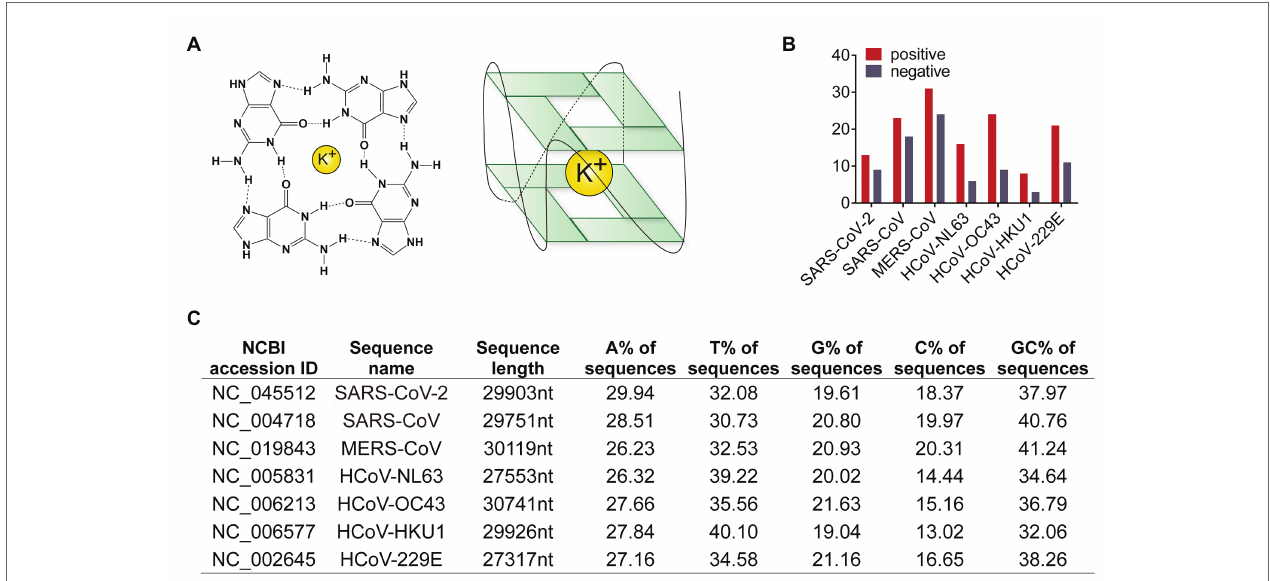
FIGURE 1 | Human coronaviruses genomic RNA possesses G-quadruplexes. (A) Schematic diagram of G-quadruplex structure. Guanines forming G-tetrad structure with a potassium ion inside for stable. (B) Numbers of predicted G-quadruplex forming sites in seven human coronaviruses. The red column represents the G-quadruplex numbers in positive strand, and the gray showed the number in negative strand. (C) Sequence features of human coronavirus genomes. Lane one to three, NCBI accession ID, names, and sequence length of genome reference sequences. Lane four to seven, the content of each base in genome sequences. Lane eight, GC content in genome